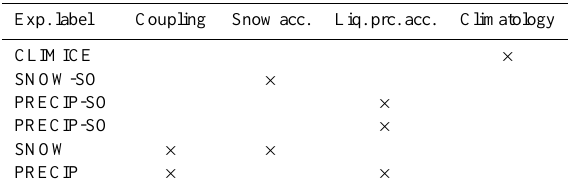
Table 1. Summary of experiments performed. “Snow acc.” stands for SNOW accumulation computation for the PDD; “liq. prc. acc.” stands for liquid precipitation accumulation for the PDD. In the case of liq. prc. acc., the accumulation given to the SMB calculations is the snow computed from the liquid precipitation and the tem- perature downscaling. “Coupling” refers to the ice–climate feed- back. “Climatology” refers to the use of observed fields instead of i LOVECLIM for the climate